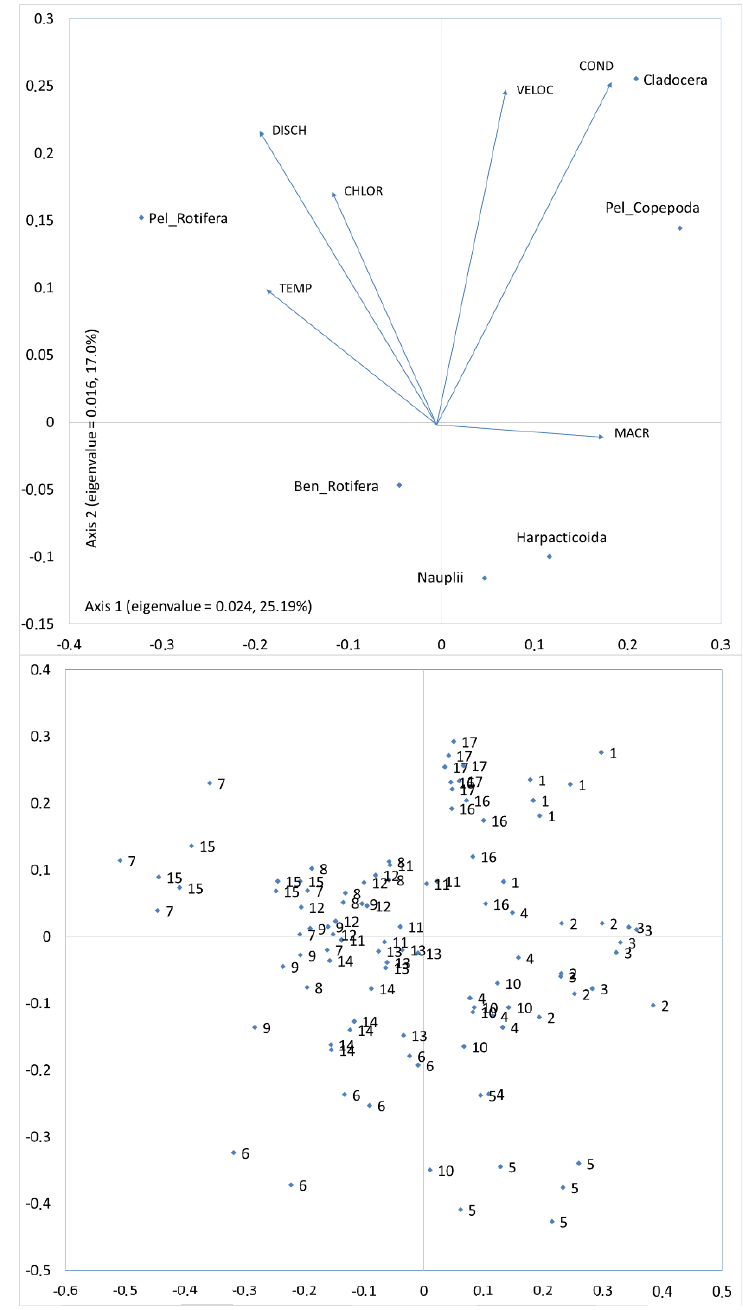
Figure 7. Zooplankton abundance along the environmental factors: CCA constrained ordination of 1 samples and taxa from sites with different current velocity in ditches with the forward selection procedure of environmental variables. Numbers indicate the sites. Environmental variables: VELOC—current velocity; DISCH—discharge; TEMP—temperature; COND—conductivity; CHLOR—chlorophyll a